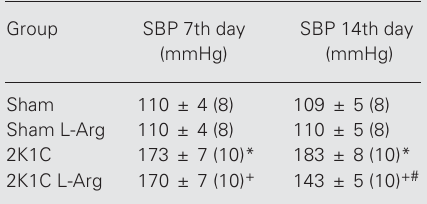
Table 1. Effects of L-arginine (L-Arg) administra- tion on basal systolic blood pressure (SBP; indi- rect measure) before (7 days after two-kidney, one-clip renovascular (2K1C) surgery) and 14 days after 2K1C surgery of normotensive sham-oper- ated and 2K1C hypertensive rats.